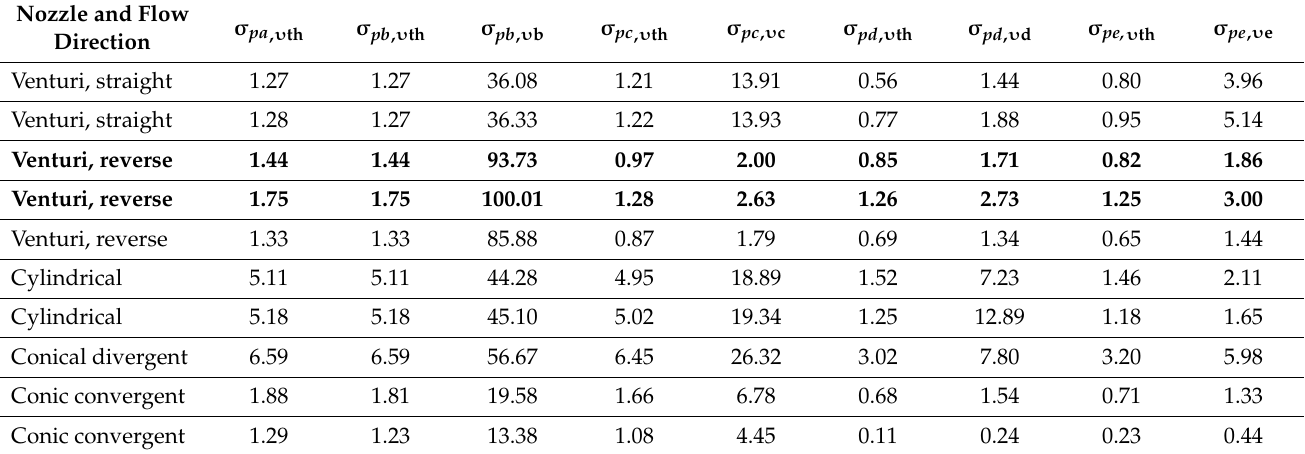
Table 2. Cavitation number (from our CFD